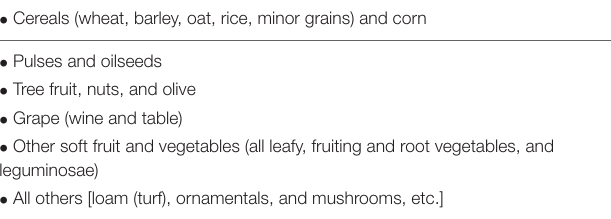
TABLE 3 | Proposed crop groupings to justify biostimulant